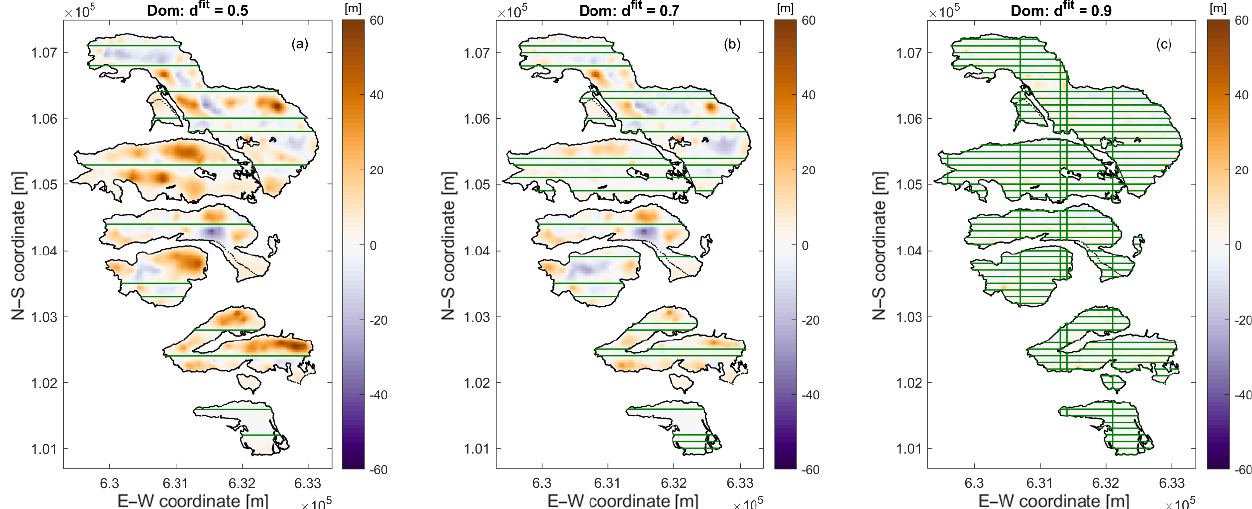
Figure 11. Dom Region model misfit h true − h est k after selected stages of the experimental design procedure using synthetic data (see also vertical dashed lines in Fig. 5). The selected GPR profiles are superimposed with green